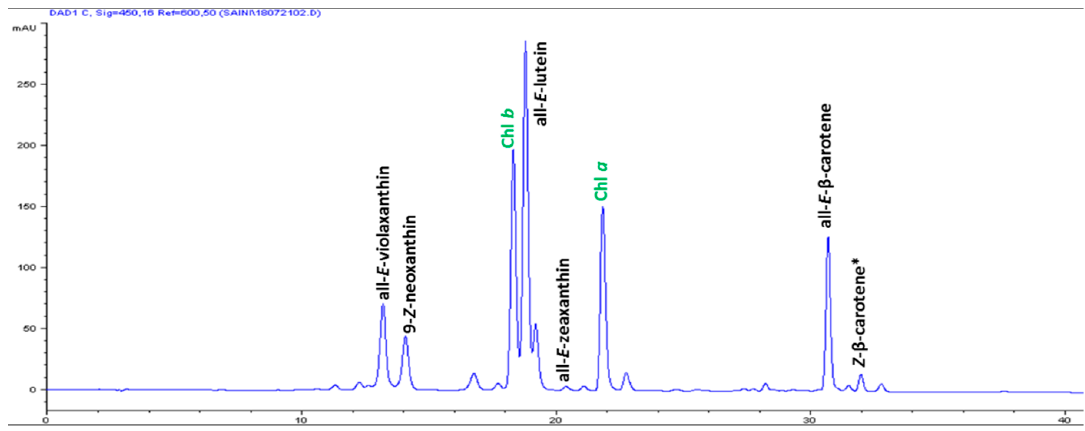
Figure 2. High-performance liquid chromatograms (HPLCs) (450 nm) of carotenoids in the leaf tissues of Mertensia maritima . Chl: chlorophyll.